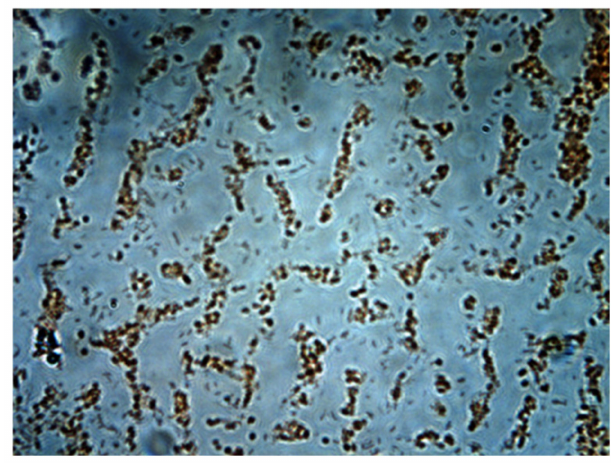
Figure 13. Gram stain of cultivable bacteria.